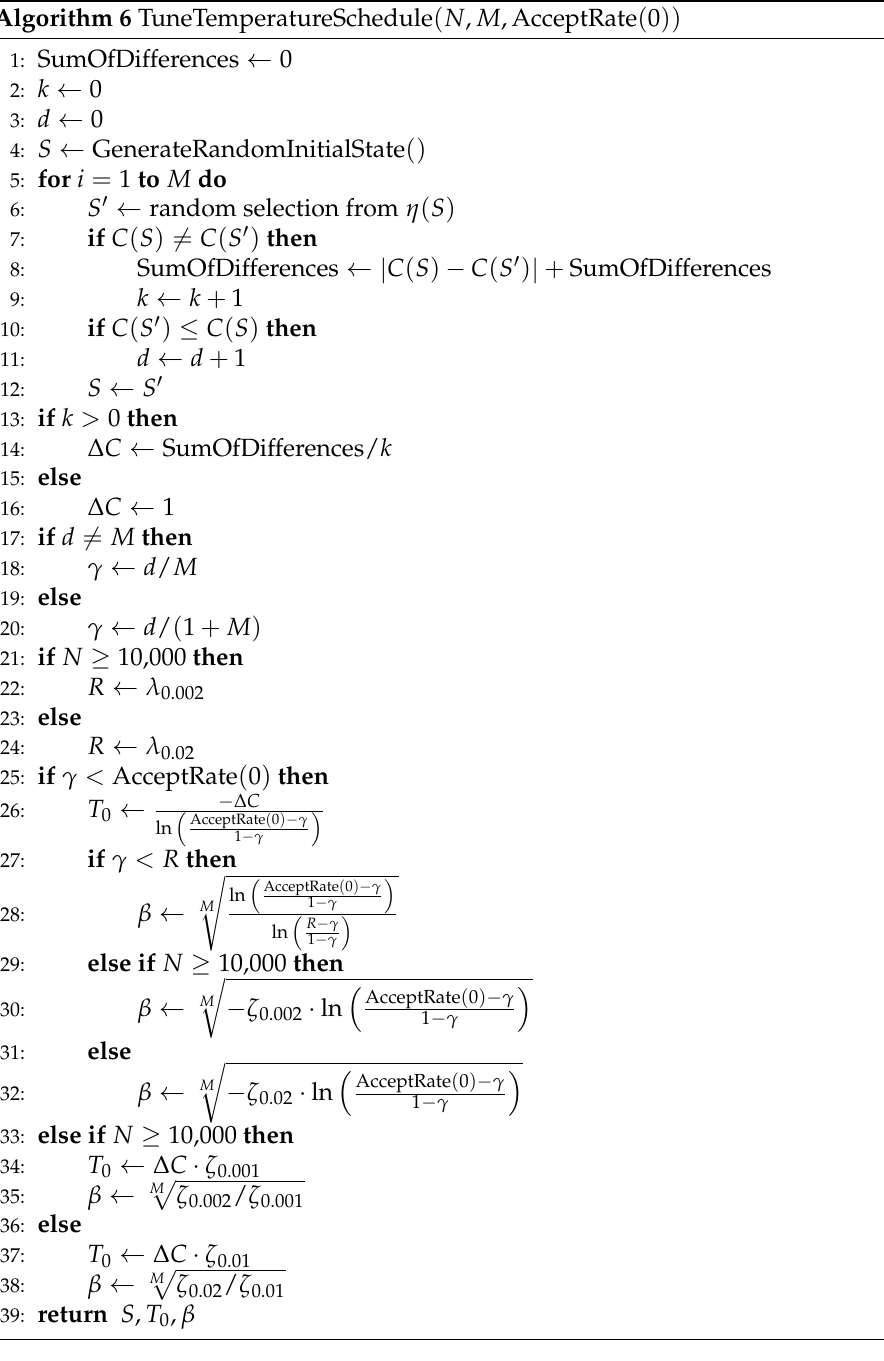
Algorithm 6 TuneTemperatureSchedule ( N , M , AcceptRate ( 0